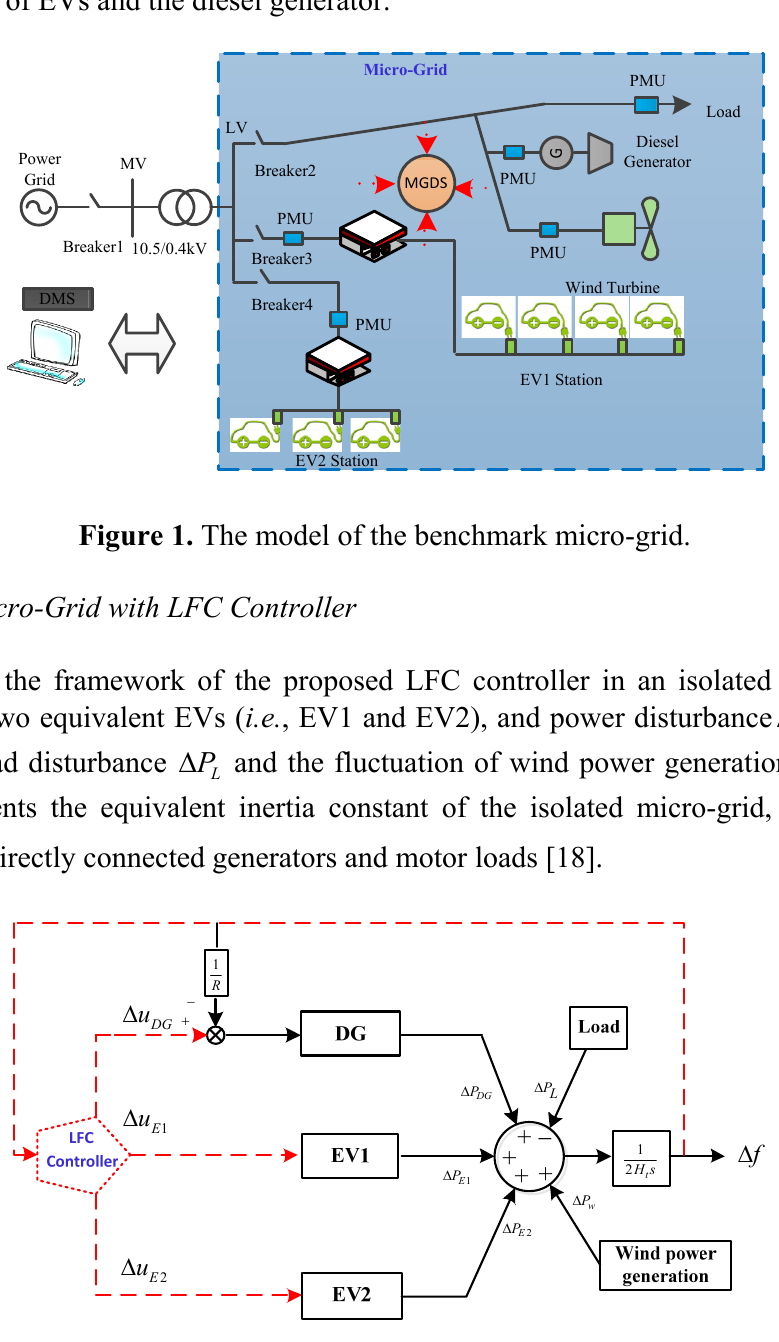
Figure 2. The control model of the micro-grid including LFC